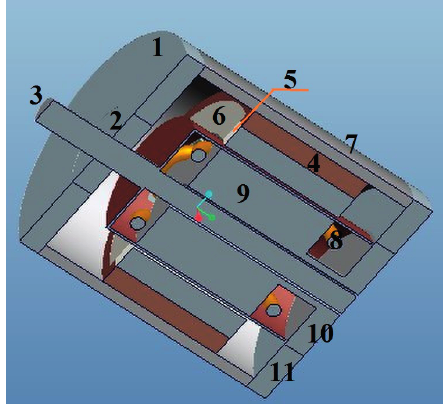
Figure 2. 3D cross-sectional view of the angular acceleration sensor.